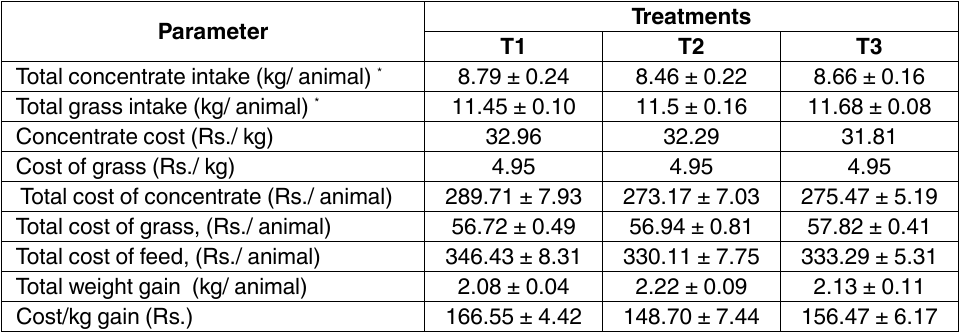
table 5. Cost per kg gain 1 of rabbits maintained on three experimental